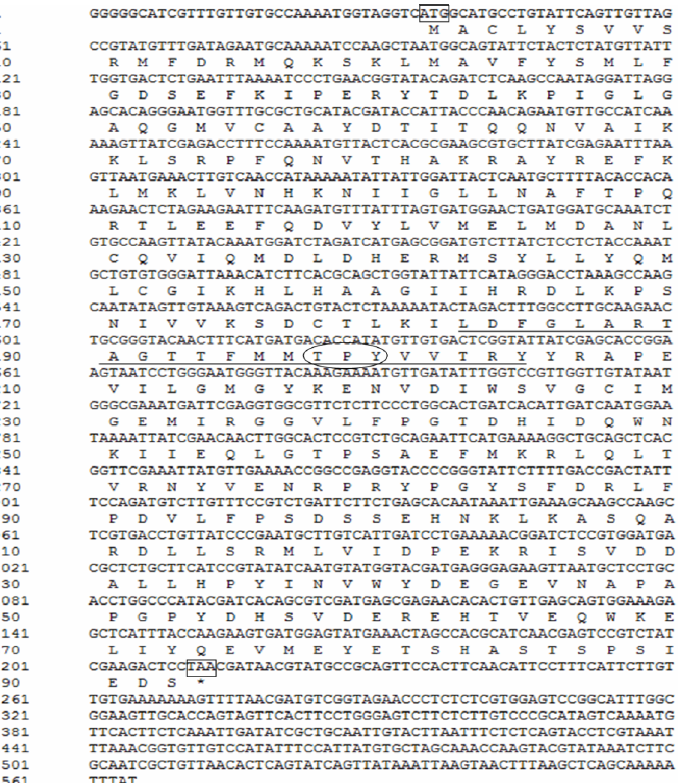
Figure 1. Nucleotide and predicted amino acid sequences of c-Jun NH (JNK) from the Mediterranean species of whitefly Bemisia tabaci complex. The start codon (ATG) and stop codon (TAG) are boxed. The active loop is underline. The conserved motif (TPY) is